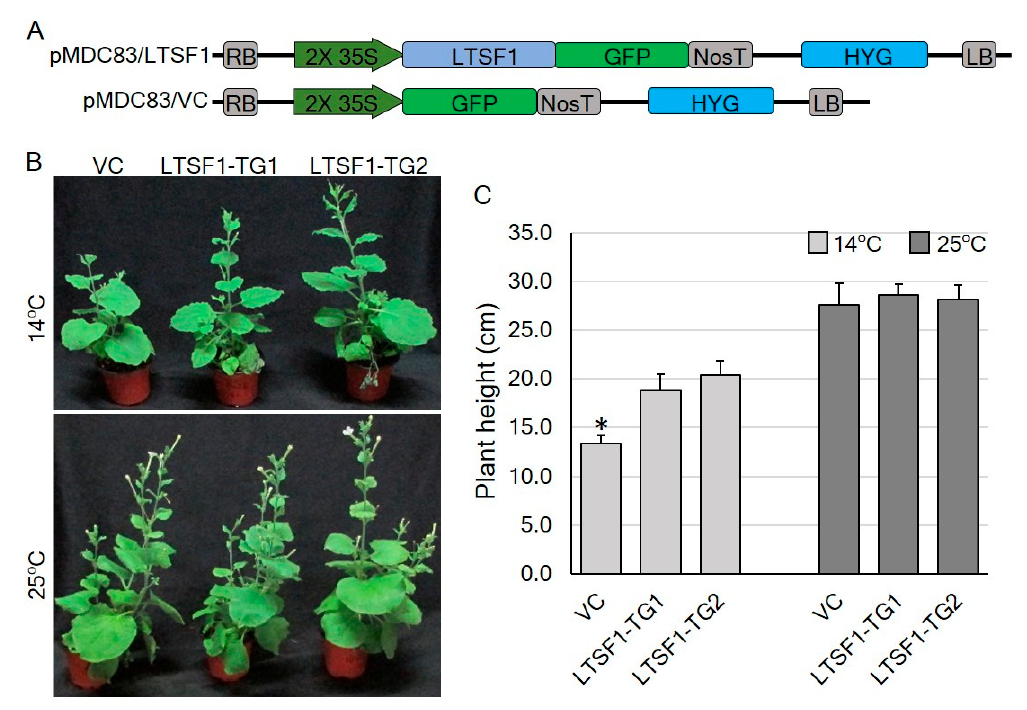
Figure 4. Transgenic N. benthamiana plants overexpressing LTSF1 . ( A ) Schematic diagram of the transfer DNA (T-DNA) region of the pMDC83 / VC and pMDC83 / LTSF1 vectors: RB, right border of T-DNA region; LB, left border of T-DNA region; 2 × 35S, Cauliflower Mosaic Virus 35S promoter; HYG, hygromycin phosphotransferase gene; NosT, nopaline synthase terminator. ( B ) Phenotype of the LTSF1 -overexpressing and vector control (VC) transgenic N. benthamiana plants after 30 days of low-temperature stress (14 ◦ C). ( C ) Plant heights of the LTSF1- overexpressing transgenic and VC plants under temperature stress (14 ◦ C) and normal conditions (25 ◦ C). The error bars indicate the mean ± SD of six biological replicates. * p < 0.01 vs. control (VC).